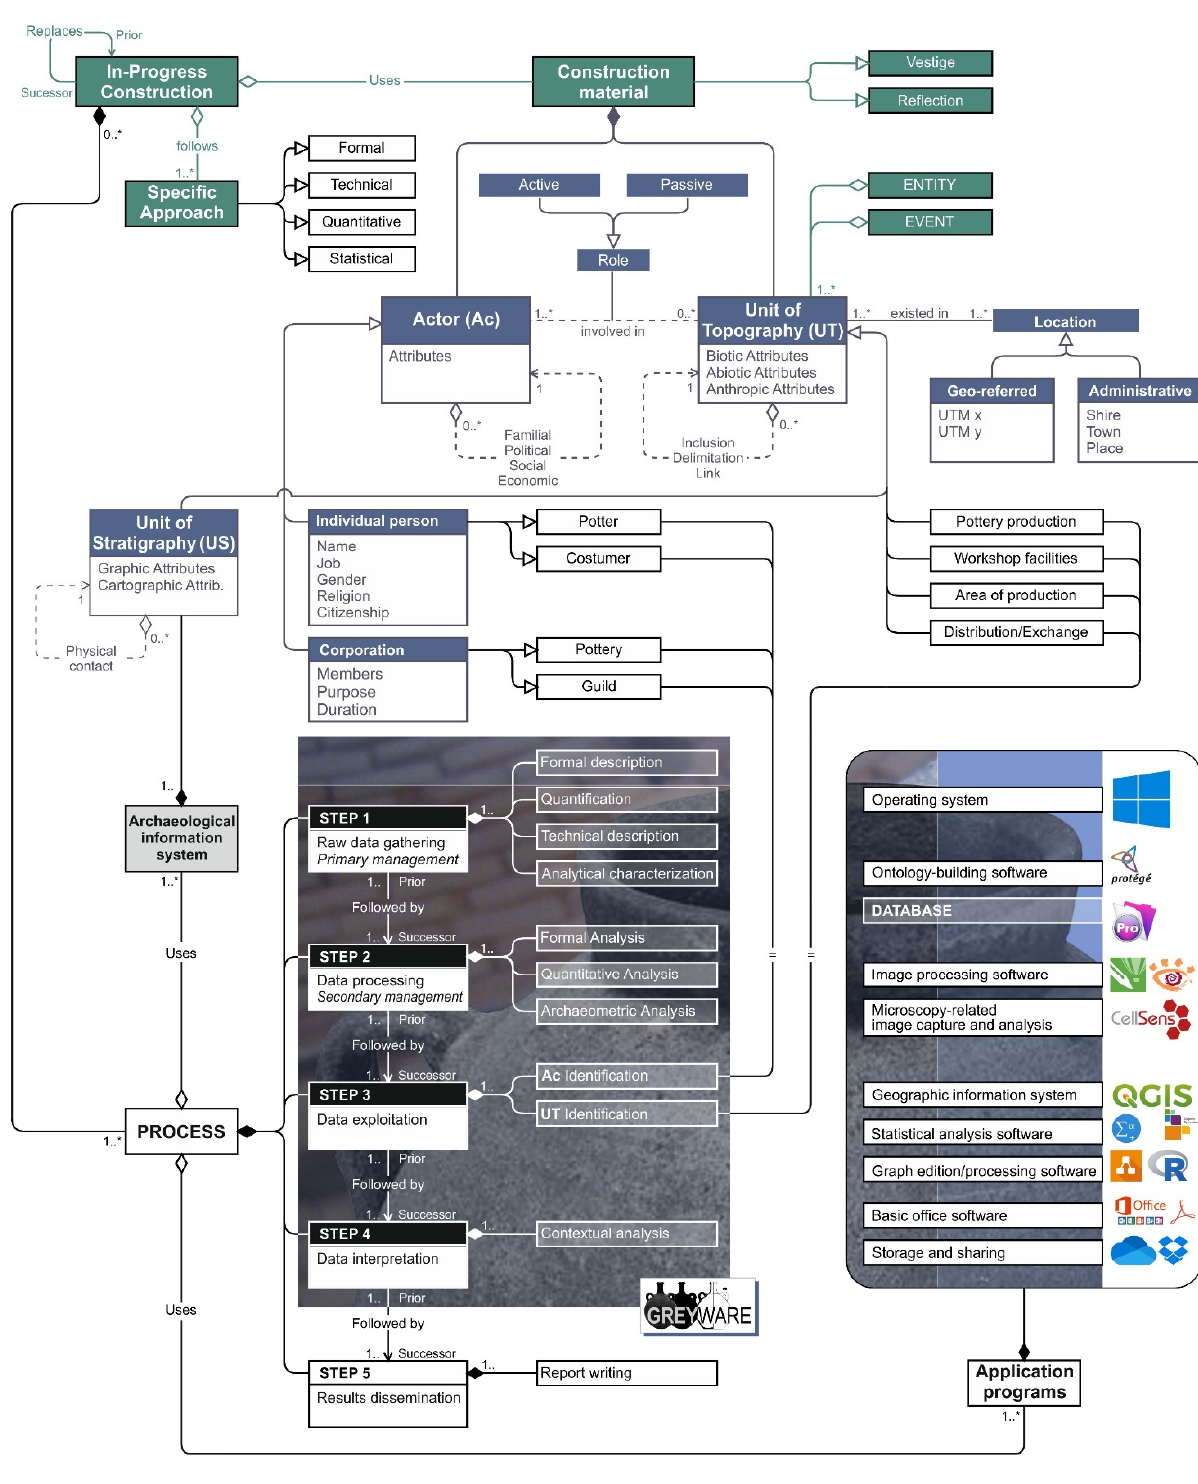
Figure 4. UML diagram of G REYWARE ’s overview and components. Classes described by the H ORAI UT/Ac data model are represented in blue. Their relation with top-level entity-event ontologies [11,35] are highlighted in green. Categories defined in pottery studies (and thus in domain or task ontologies) included in the G REYWARE data-modelling are represented in black and white. The central area shaded by the project’s interface identifies the processes developed in the classification chart shown in Figure 2 and the application programs used to perform research tasks. Process components included in the G REYWARE database are shaded in